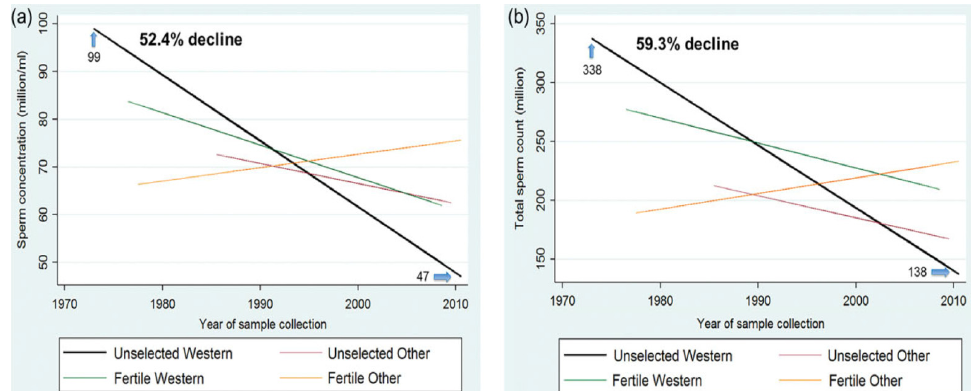
Figure 1. ( a ) Meta-regression model for mean sperm concentration by fertility and geographic groups, adjusted for potential confounders. ( b ) Meta-regression model for mean total sperm count by fertility and geographic groups, adjusted for potential confounders. Reproduced under licence N ◦ 5070710881460 from: Levine H, Jørgensen N, Martino-Andrade A, Mendiola J, Weksler-Derri D, Mindlis I, Pinotti R, Swan SH. Temporal trends in sperm count: a systematic review and meta-regression analysis. Hum Reprod Update. 2017 Nov 1;23(6):646–659, doi:10.1093/humupd/dmx022. PMID: 28981654; PMCID: PMC6455044) [13].